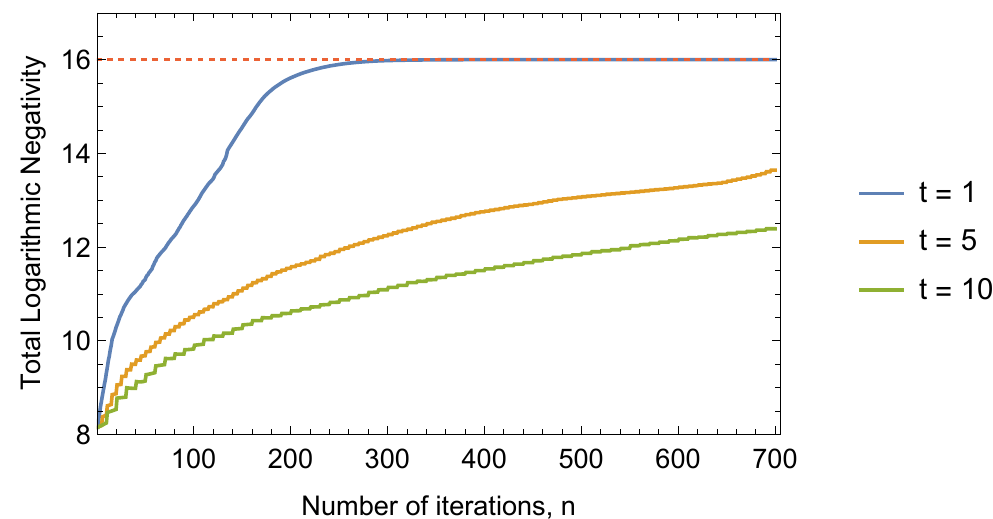
Figure 9. Sum of logarithmic negativity of all bipartite cuts of the eight-qubit system throughout QZD with three choices for greediness, t = 1, t = 5, and t = 10, as explained in the flowchart of the algorithm in Figure 6. The greediest choice t = 1 performs the best, driving the system to a maximally LN ( σ i :8 − i ) ≈ 16 in only around 300 entangled state with ∑ 7 i = 1